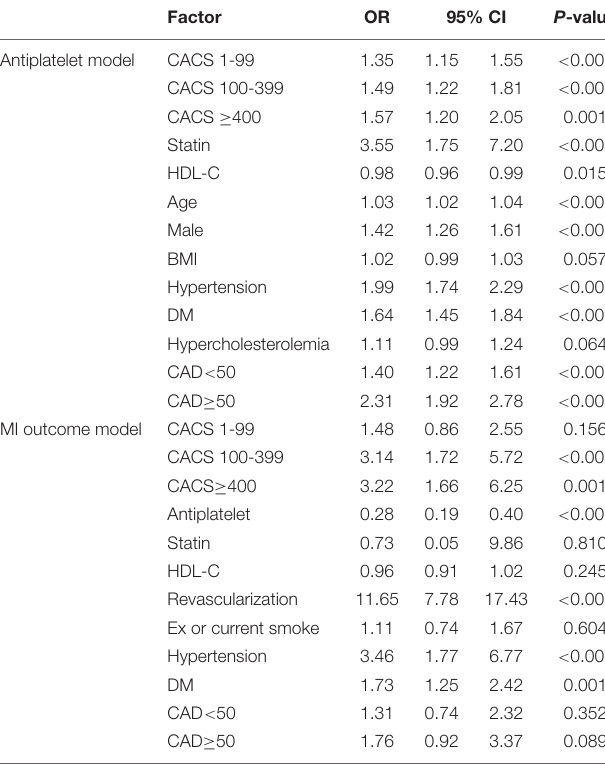
TABLE 2 | Factors associated with MI diagnosis: multiple logistic regression. Factors 95% CI